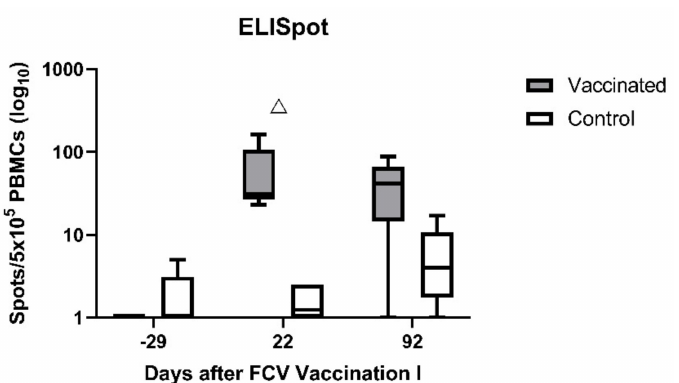
Figure 5. Box and whisker plots of the number of IFN- γ -releasing PBMCs after stimulation with the vaccine virus FCV F9. The line inside the box shows the median, and the lower and upper border of the box indicates the 25th and 75th percentile, respectively. Whiskers represent minimum and maximum values. Significant differences between the vaccinated group and the control are indicated with an open triangle; (cid:52) denotes significantly higher in the vaccinated group P MWU ≤ 0.05. The second injection of FCV Vaccination I was performed at day